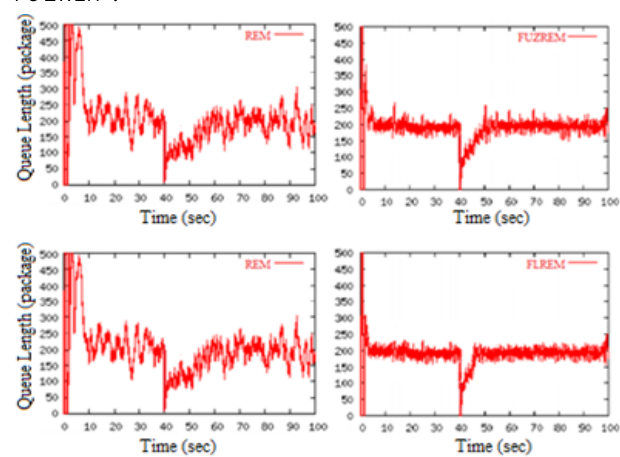
Figure 10. Ability to respond of REM, FUZREM,